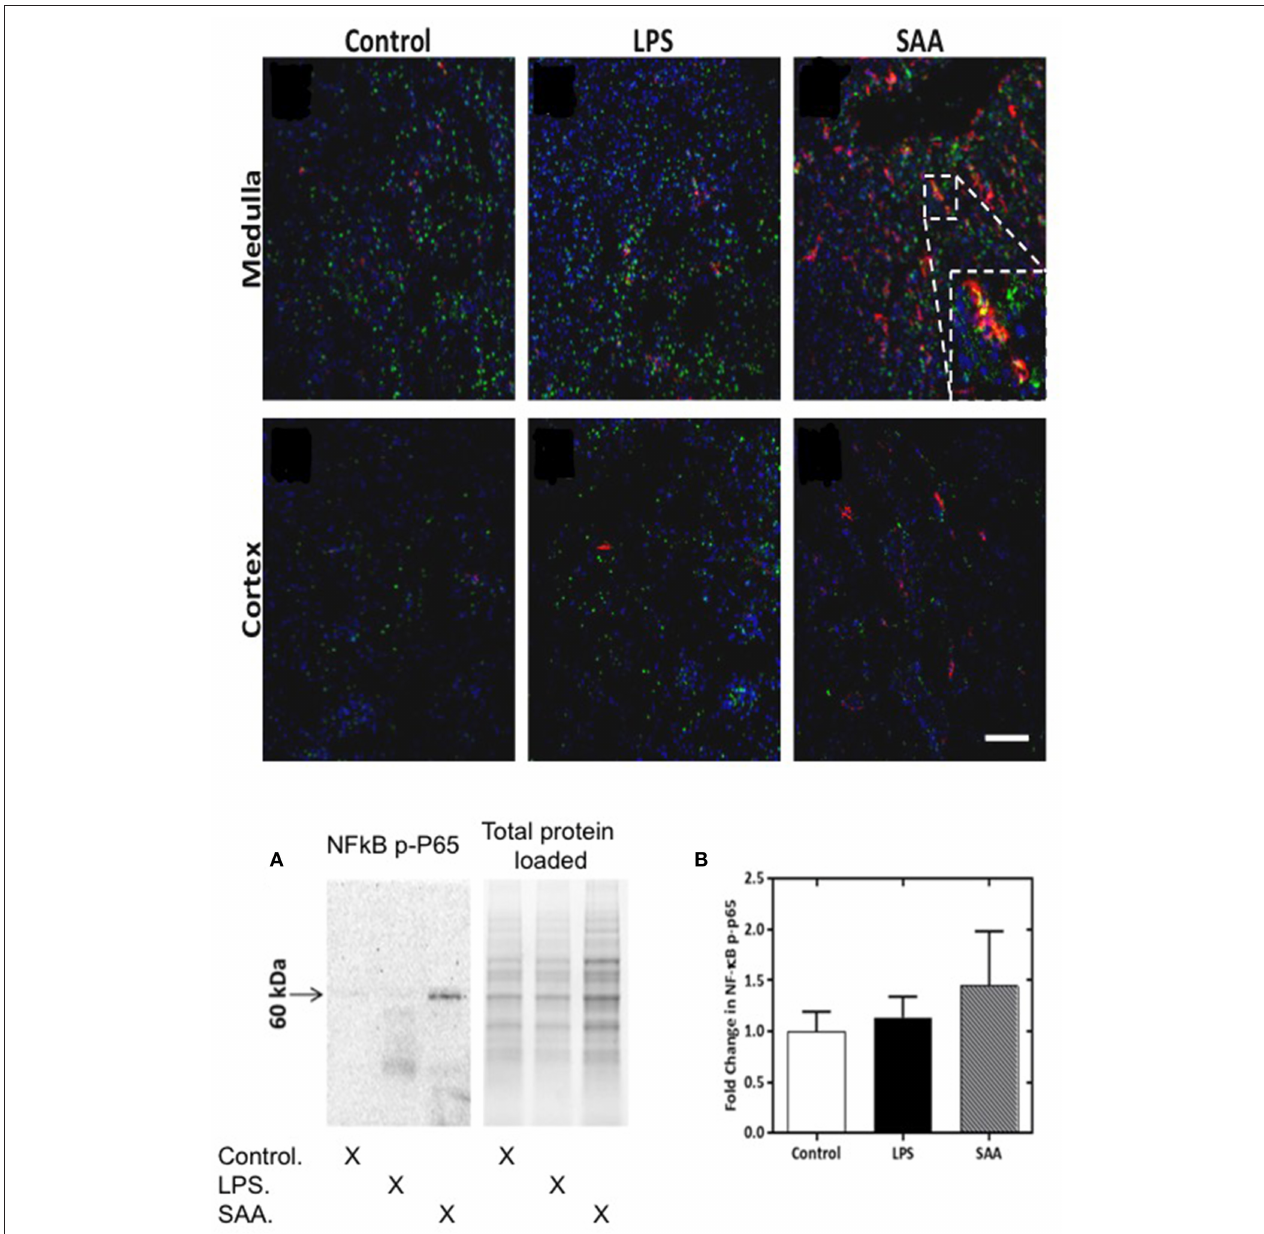
FIGURE 6 | NF κ B phospho-p65 is increased in SAA-treated ApoE − / − mice kidney. ApoE − / − mice were administered SAA, LPS or sterile PBS and kidneys harvested 3 days later. Tissue sections were incubated with anti-mouse NF κ B P -P65 Ser267 (FITC) and anti-mouse F4/80 (Alexafluor 594). Representative views ( x 200 magnification) are shown for renal medulla (Upper and cortex (Lower) from control, LPS- and SAA-treated mice. Where NF κ B P -P65 + immunoreactivity (Ser267) labeling (green) co-registered with F4/80 + immunoreactivity labeling (red) cells appear yellow. Figure inset shows magnified region highlighting NF- κ B P -P65 + and F4/80 + immunoreactivity and co-registration of these antigens in the renal medulla. Scale bar = 100 µ m. NK- κ B P -P65 levels in SAA-treated ApoE − / − mouse kidney tissue homogenates were examined by Western blot (A) and normalized to total (in-gel) protein as shown in (B) . Data are means ± SD ; n = 2 experiments performed in duplicate.